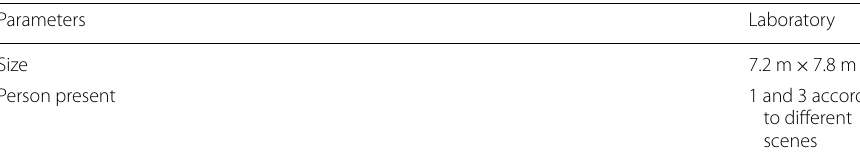
Table 2 Parameters of